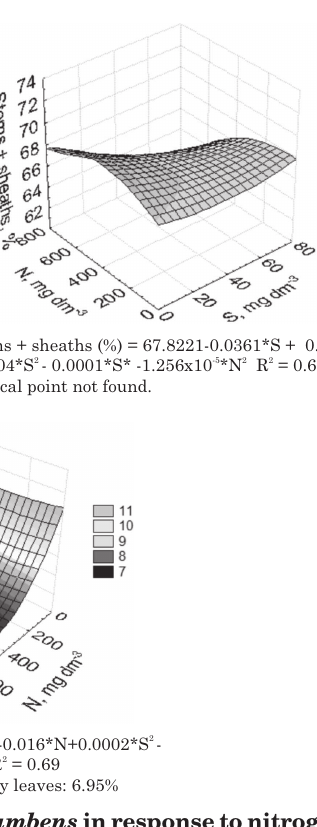
Figure 1. Production of tillers and dry matter (DM) of green leaves and of stems + sheaths and total DM of Brachiaria decumbens fertilized with nitrogen and